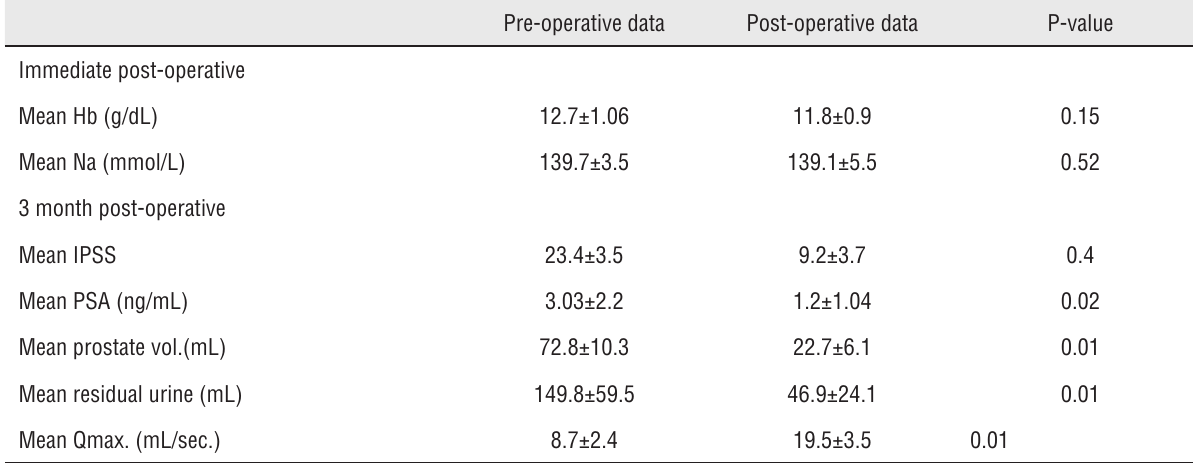
Table 1 - Pre-operative and post-operative data of the